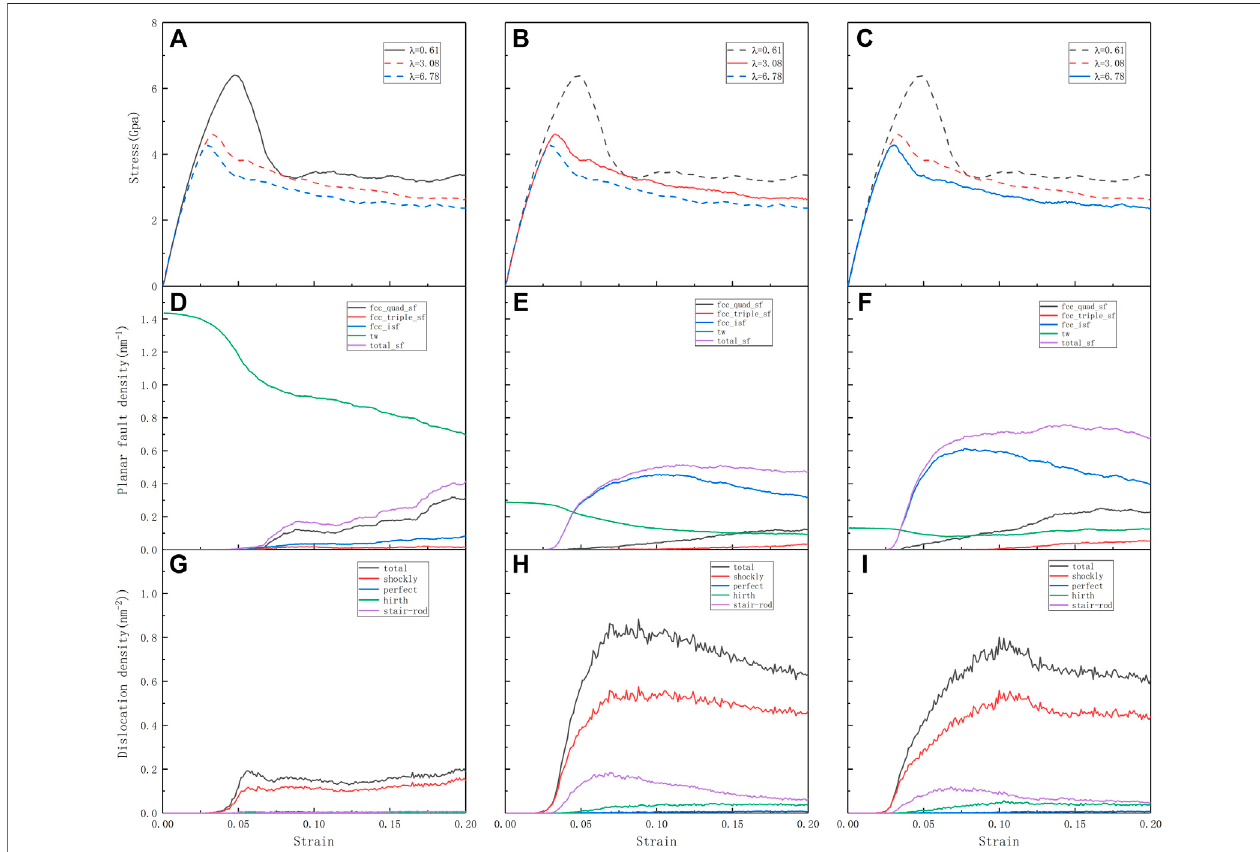
FIGURE 6 | (A – C) Tensile stress-strain curves for the different twin spacing nt-HEAs ( λ = 0.61, λ = 3.08, λ = 6.78) and deformed along the [111] crystallographic directions, respectively. The corresponding (D – F) planar fault (TB and SF) densities and (G – I) dislocation densities as functions of strain, respectively.